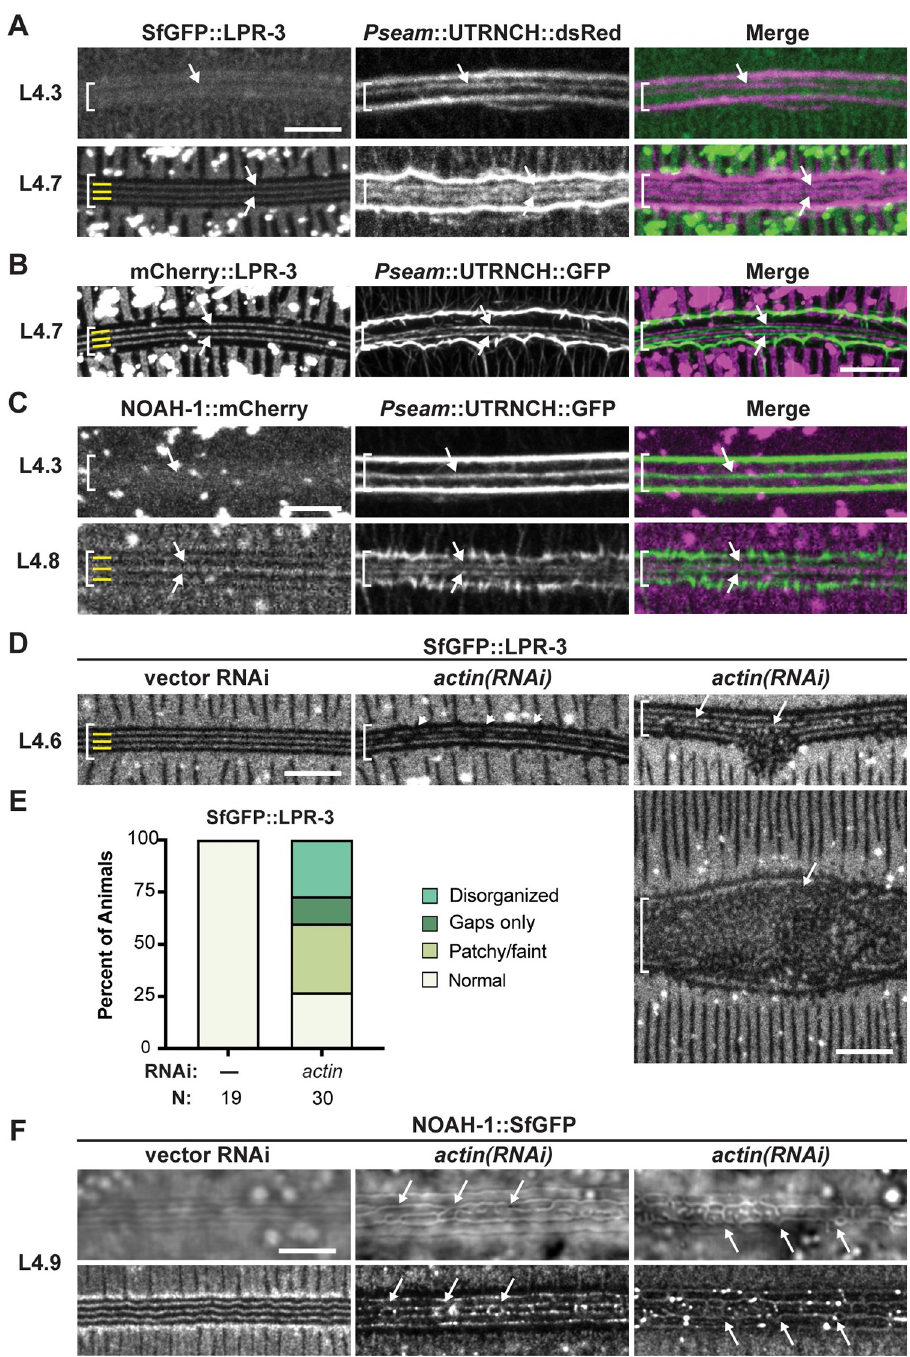
Fig 8. Actin is required to pattern the provisional matrix. (A-C) Spatial relationships between seam AFBs and provisional matrix bands. Maximum intensity projections of animals expressing the designated actin sensor and matrix fusion. Brackets indicate seam region. Arrows point to medial AFBs. Images are representative of at least n = 6 per strain per stage. (A,B) LPR-3 apical bands are largely offset from AFBs (strains UP4127 and UP4170, 20˚C). For A, only specimens where the UTRNCH::dsRed sensor detected medial AFBs in addition to junctional AFBs could be assessed. (C) NOAH-1::SfGFP apical bands are largely offset from AFBs (strain UP4114, 20˚C). D) actin RNAi disrupts LPR-3 provisional matrix patterns. Standard methods for bacterially-induced actin RNAi were used, and surviving animals were imaged at the L4.5-L4.7 stage (strain UP3666, 20˚C). Middle panel shows example of a patchy and faint pattern. Right panels show examples of disorganized patterns. (E) Quantitation of SfGFP::LPR-3 patterns after